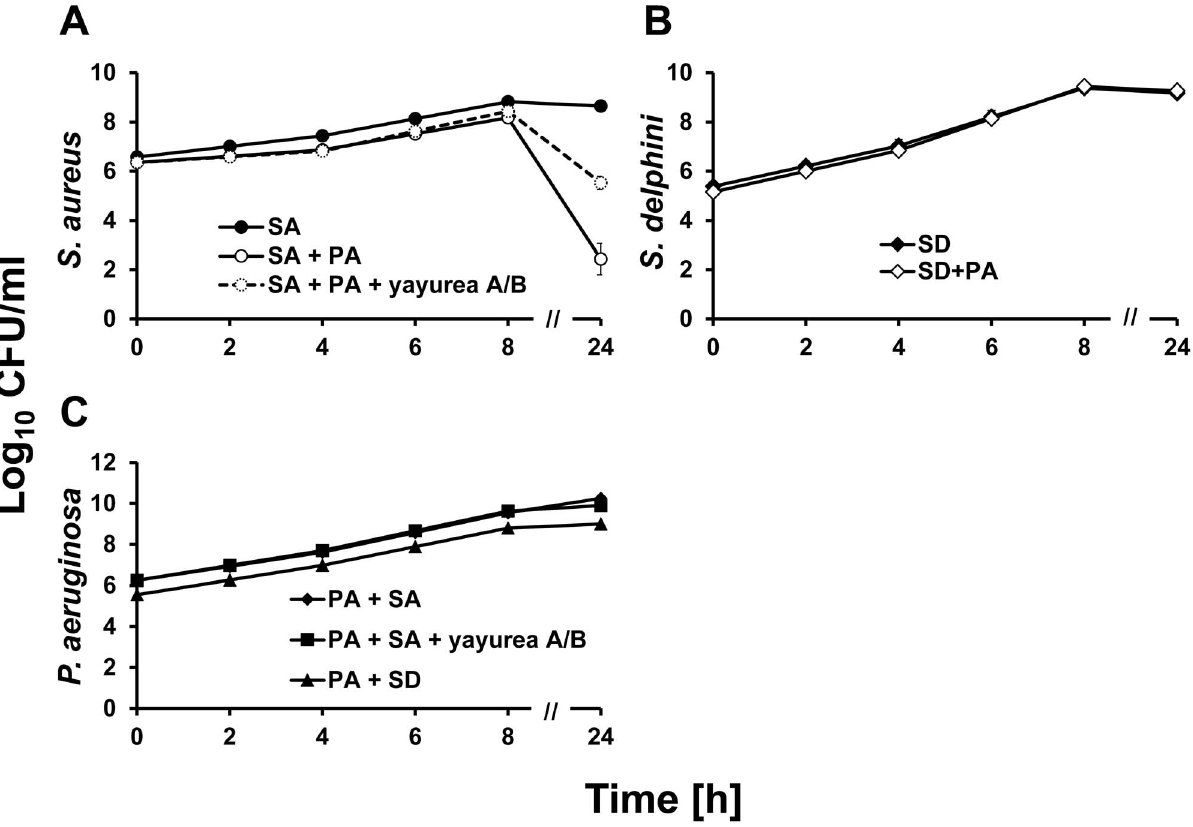
Figure 3. Survival of staphylococcal strains in mixed culture with P.aeruginosa . ( A ) CFU of S. aureus alone (SA) and in co-culture with P. aeruginosa (SA + PA). For the protection test, yayurea A (100 m g/ml) and B (900 m g/ml) were added to the mixture of S. aureus and P. aeruginosa (SA + PA + yayurea A/B). ( B ) CFU of S. delphini alone (SD) and in co-culture with P. aeruginosa (SD + PA). ( C ) CFU of P. aeruginosa SH1 co-cultured with S. aureus (PA + SA), yayureas (PA + SA + yayurea A/B) or S. delphini (PA + SD). Values represent the means of three independent experiments. Bars indicate mean standard deviation, SD. doi:10.1371/journal.ppat.1003654.g003 PLOS Pathogens |